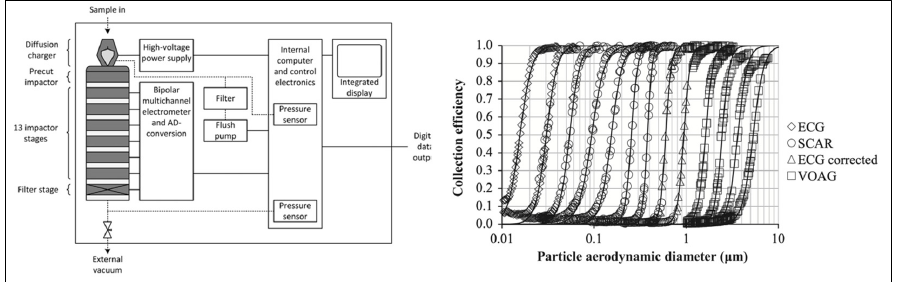
Figure 8. A schematic of the operating principles of the ELPI and particle size distributions on each